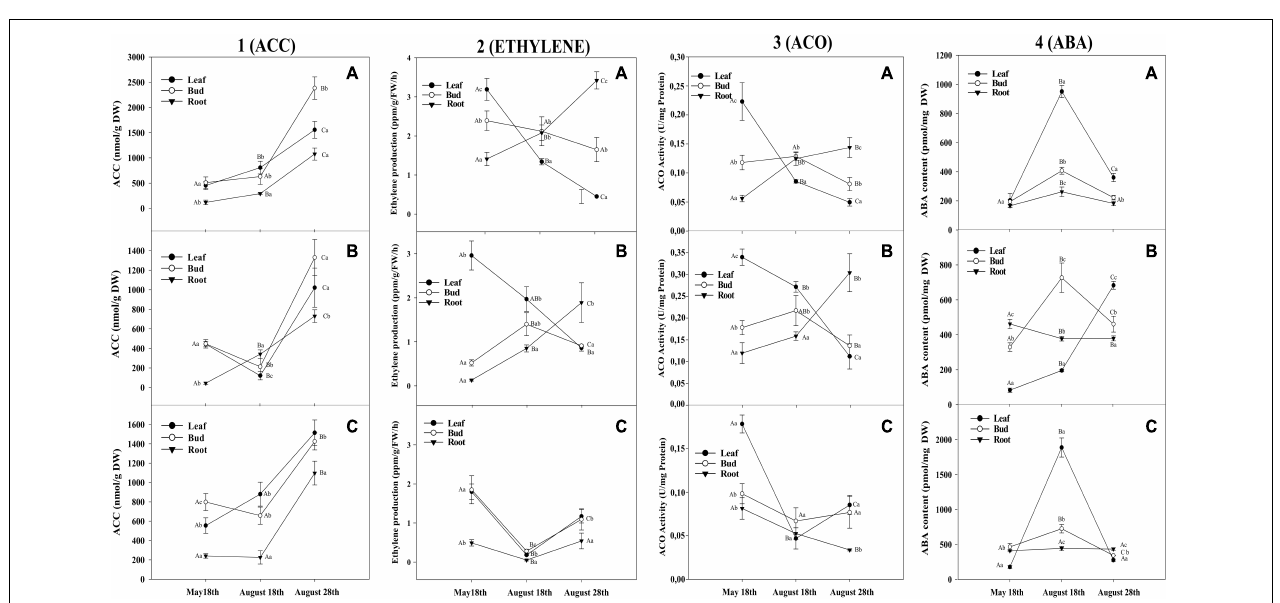
FIGURE 1 | Predawn leaf water potential for coffee genotypes. (A) Coffee plants from field experiment I in the rainy period (May 18th), dry period (August 20th), and re-watering period (August 28th) for Oeiras, Acauã, and Semperflorens genotypes. (B) Coffee plants from field experiment II in the re-watering period (August 28th) for Paraiso 2 coffee cultivar. Data are the mean ± 95% of SD of the mean ( n = 8). Different letters within the same period indicate statistical ( P < 0.05) differences within the same period, respectively.